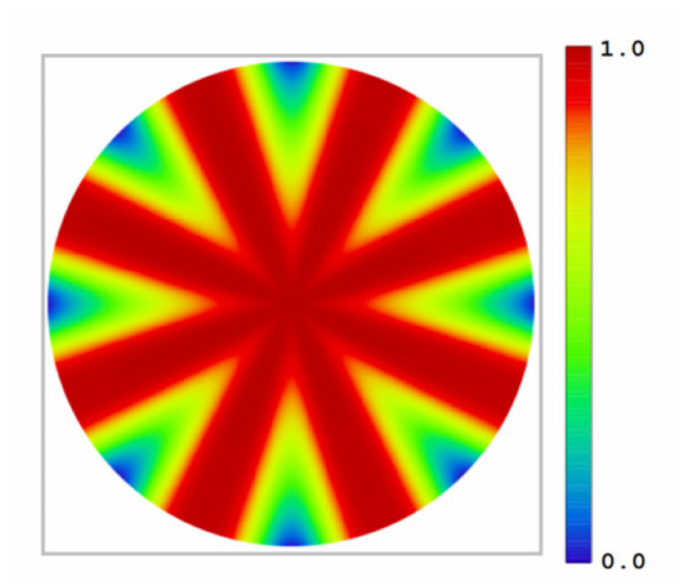
Figure 5. Spindle star error; normalized surface height. A TM pattern observed in SPDT typically close to the rotation axis of the optic. Related to tool wear and